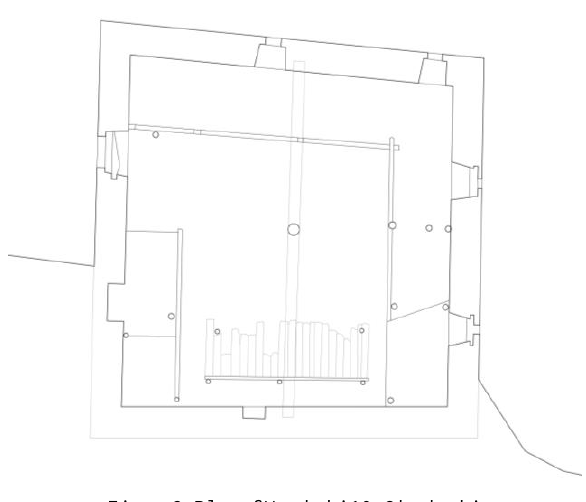
Figure 2. Plan of Machubi 10, Chazhashi, Ushguli, CI-ESG, 2019.